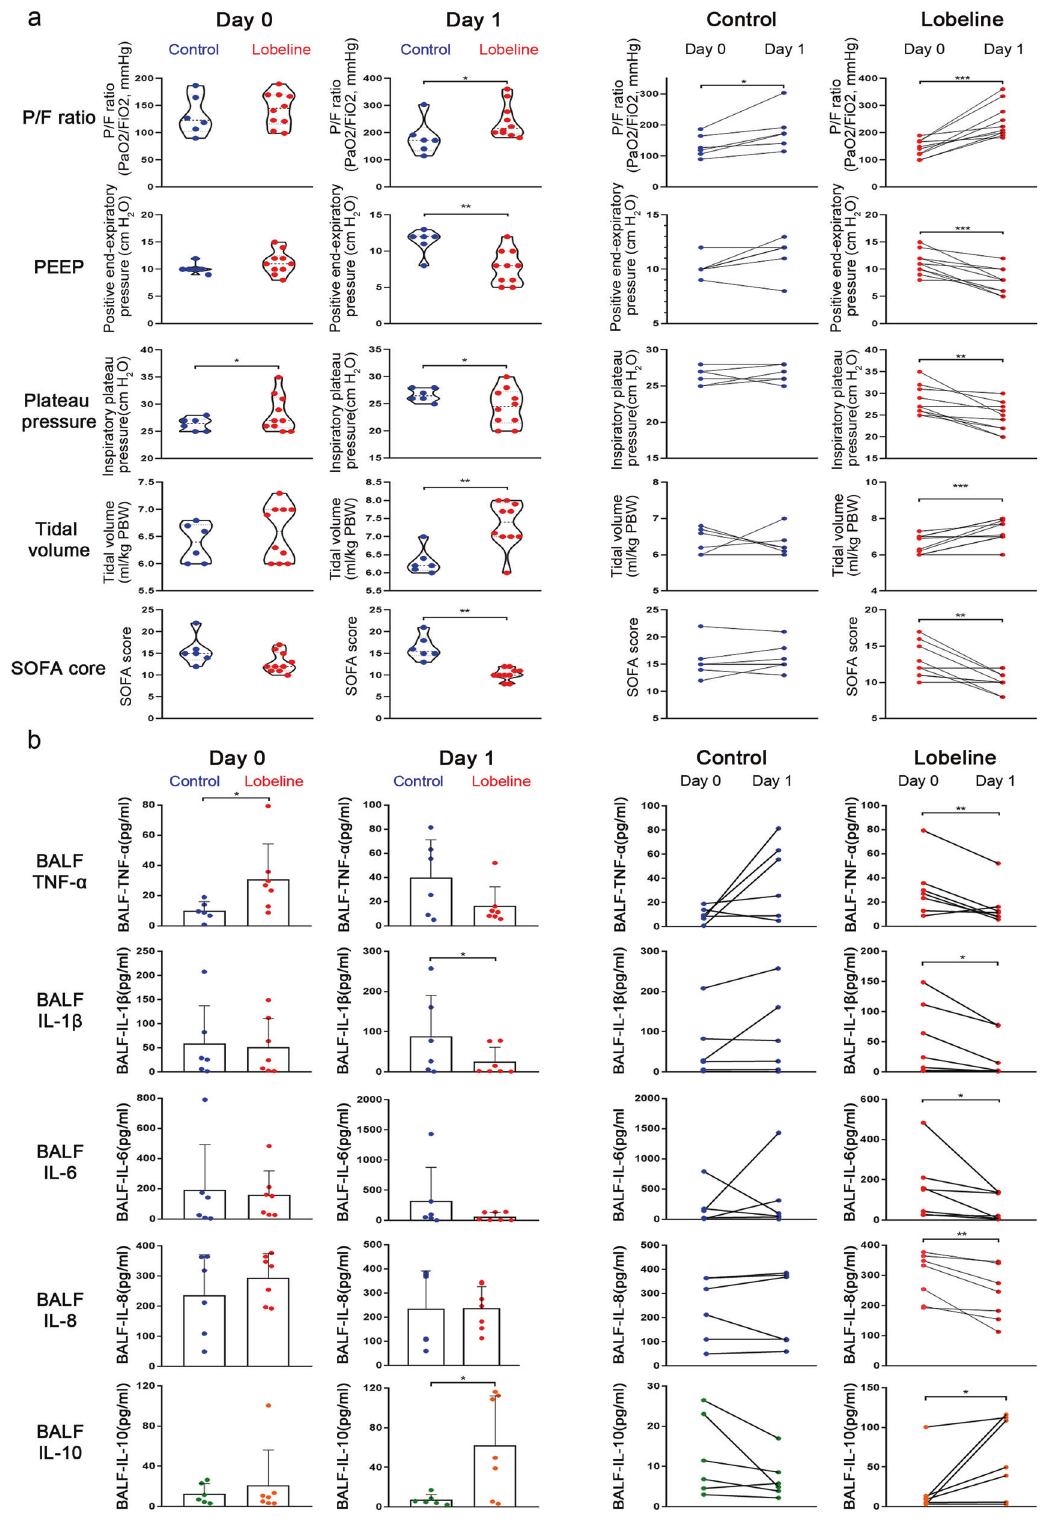
Fig. 6 Lobeline improves the respiratory symptoms of ARDS patients. a Analysis of pulmonary ventilation index and multiple organ assessment. P/F ratio [PaO 2 (mmHg)/FiO 2 (%)], plateau pressure, positive end-expiratory pressure, tidal volume, and SOFA score were measured from day 0 to day 1 from two groups. b Analysis of in fl ammatory factors in BALF from two group patients. IL-8, IL-1 β , TNF- α , IL-6, IFN- γ , IL-10 ELISA kits were used to determine BALF in fl ammatory concentrations